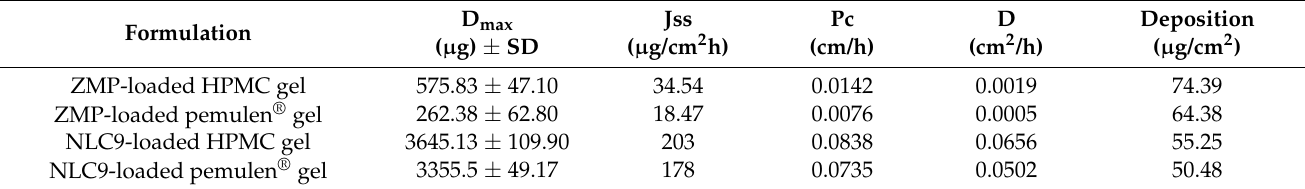
Figure 9. Histopathological examination of shaved rabbit dorsal skin treated with NLC9-loaded HPMC gel for three consecutive days (100×).